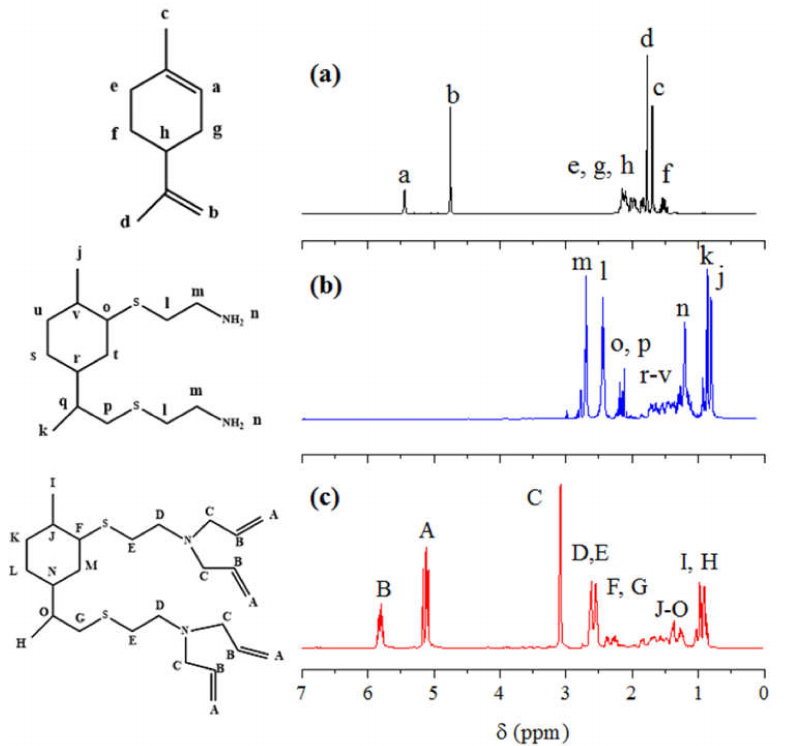
Figure 2. Comparison of the 1 H NMR spectra of: ( a ) pristine limonene, ( b ) intermediate LC compound and ( c ) curing agent LCA. All samples were run in CDCl 3 in a 500 MHz